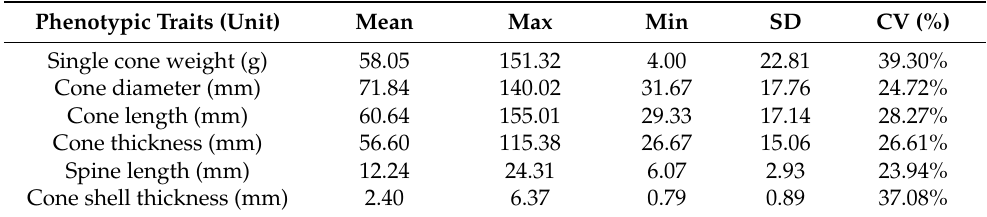
Figure 2. Cone seed atlas of di ff erent cultivars of the Castanea germplasm resources.